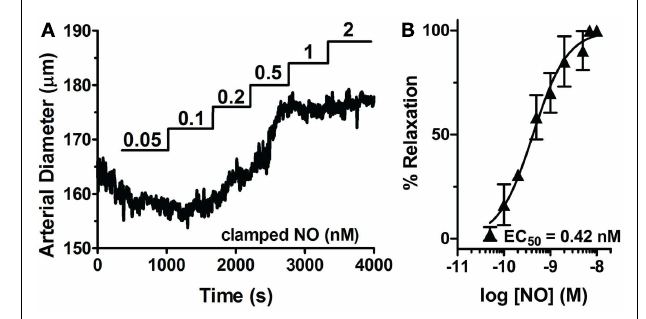
FIGURE 8 | NO delivery and vasodilation profiles are correlated in pressurized cerebral arteries. Cannulated arteries under 80mmHg were treated with (A) pulsed NO (200nM MAHMA/NO + 50 µ M CPTIO; n = 7) or (B) clamped NO (8 µ M Spermine/NO + 60 µ M CPTIO; n = 6), resulting in repeatable transient or sustained relaxations, respectively.